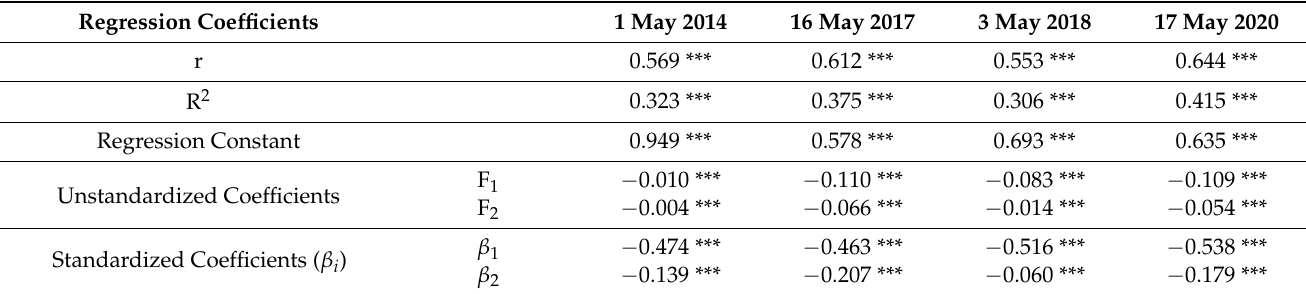
Table 8. Results of multiple linear regression between dependent variable LST N and independent variables F 1 and F 2 .